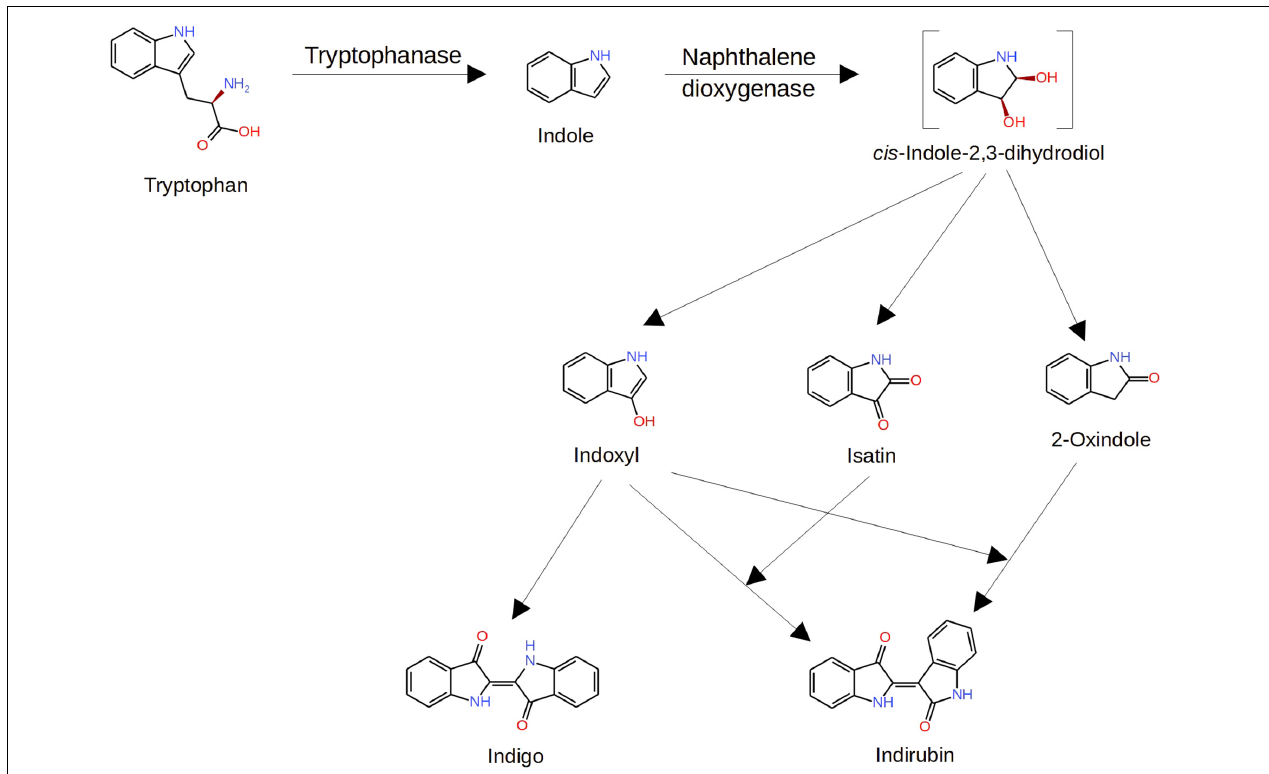
FIGURE 2 | Pathways of isatin formation from tryptophan. Modified from Zhang et al. (2014). Explanations are given in the